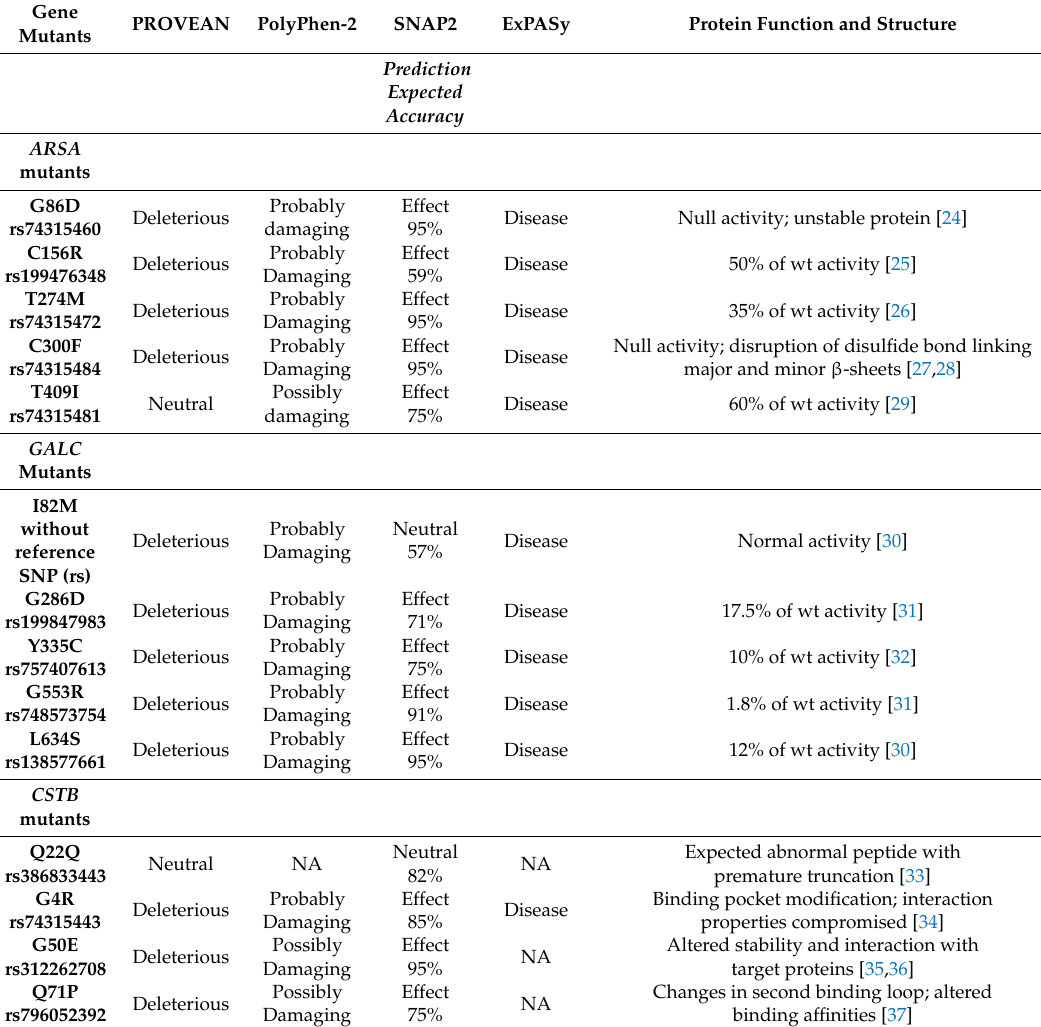
Table 2. In silico analysis of 14 other single nucleotide mutations in the genes ARSA (MIM ID